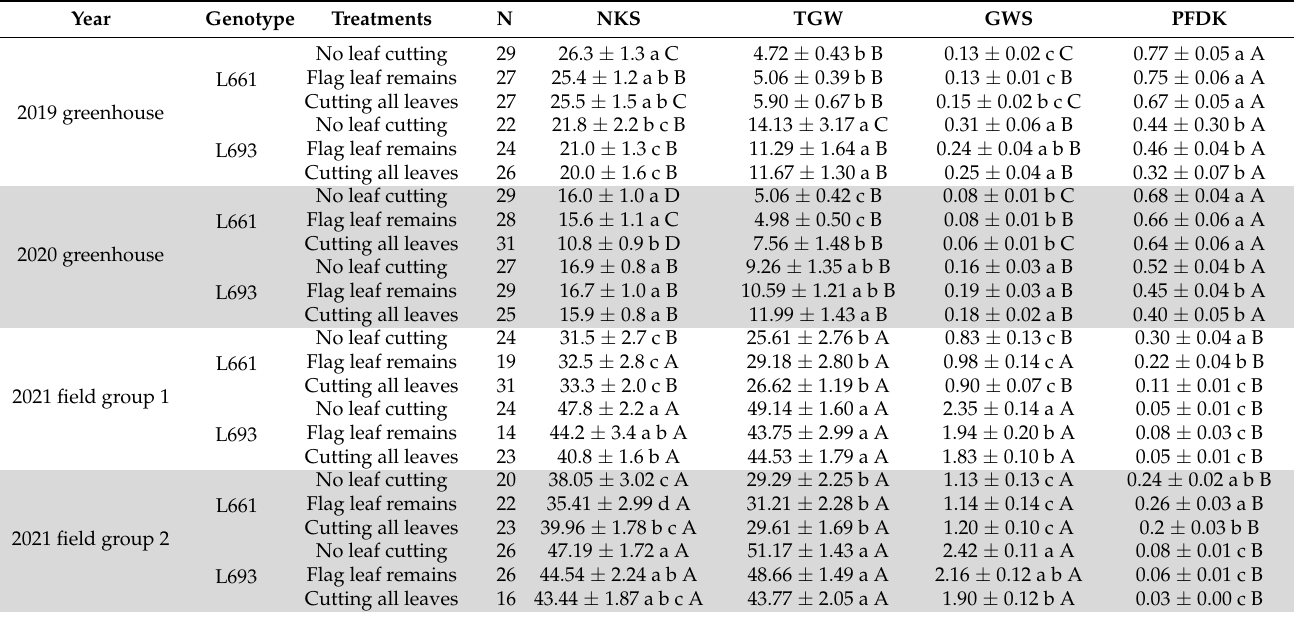
Table 2. Yield indices and PFDK in the greenhouse and